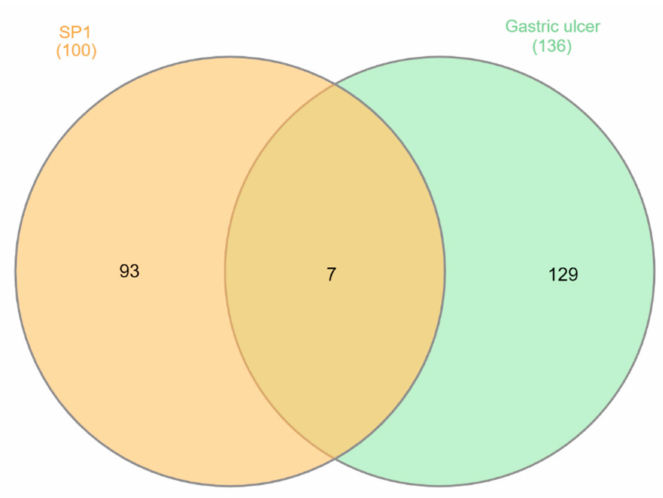
Figure 5. Venn diagram analysis for ST-1 and gastric ulcer disease (C0038358)